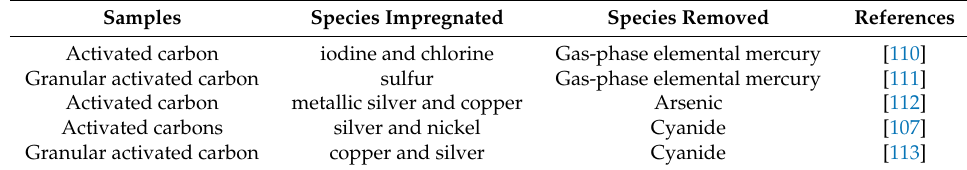
Table 4. Chemical impregnated activated carbons and their potential